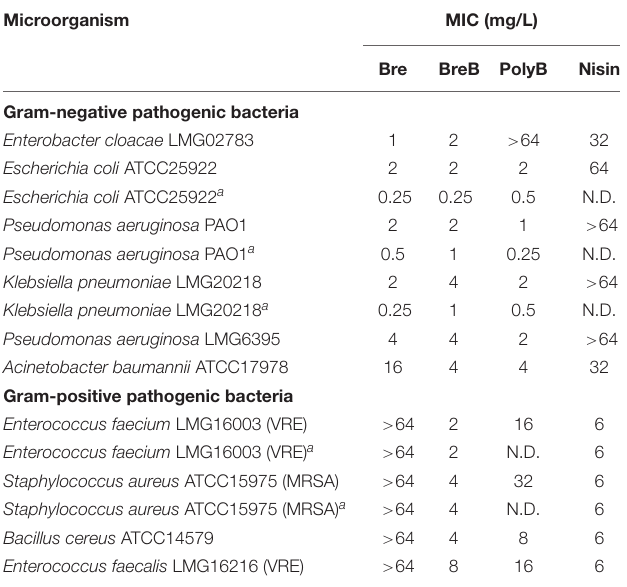
TABLE 1 | MIC values of Bre and BreB against pathogenic bacteria. Microorganism